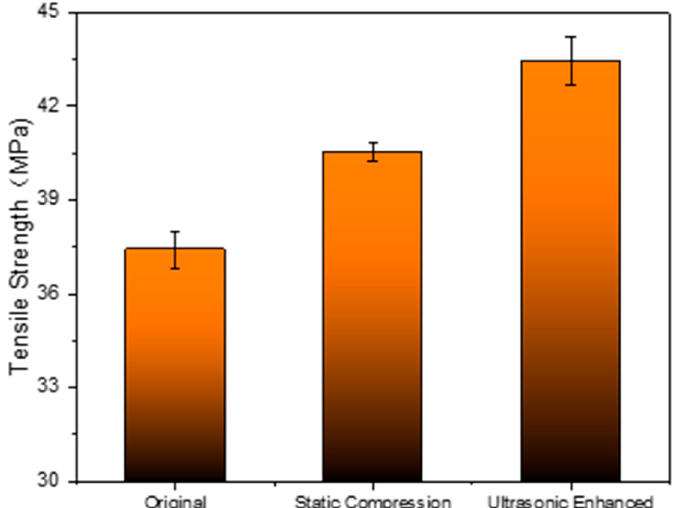
Figure 11. Comparison of static load compression and ultrasonic strengthening tensile strength.